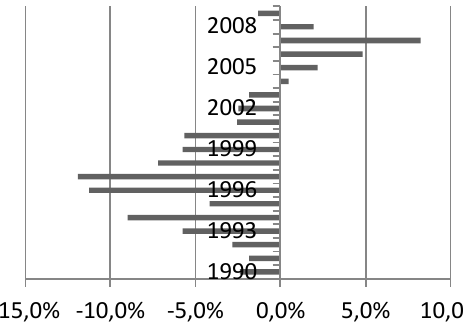
Figure 1. Manufacturing Trade Deficit (1990-2009)